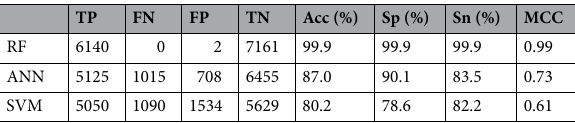
Table 2. Self-consistency testing results of all predictors.